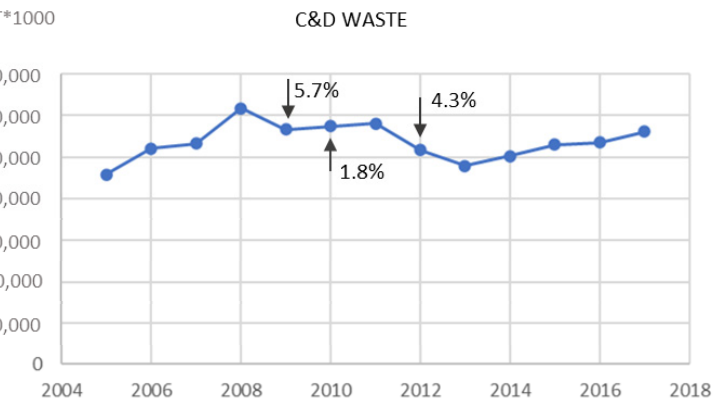
Figure 3. C&D waste production in Italy. Source: Own elaboration from ISPRA data.